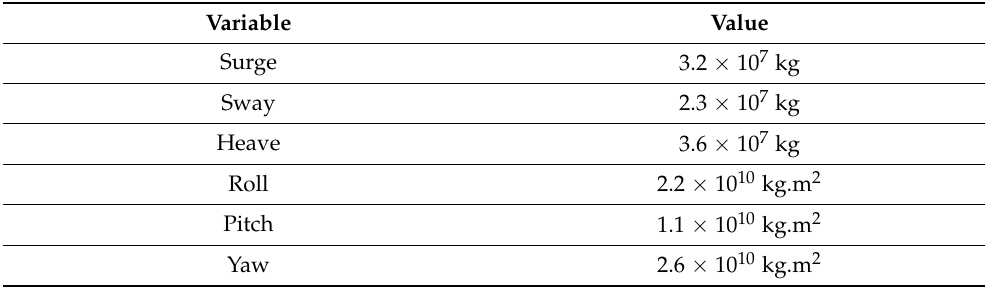
Table 8. Added mass coefficients of the floating platform.